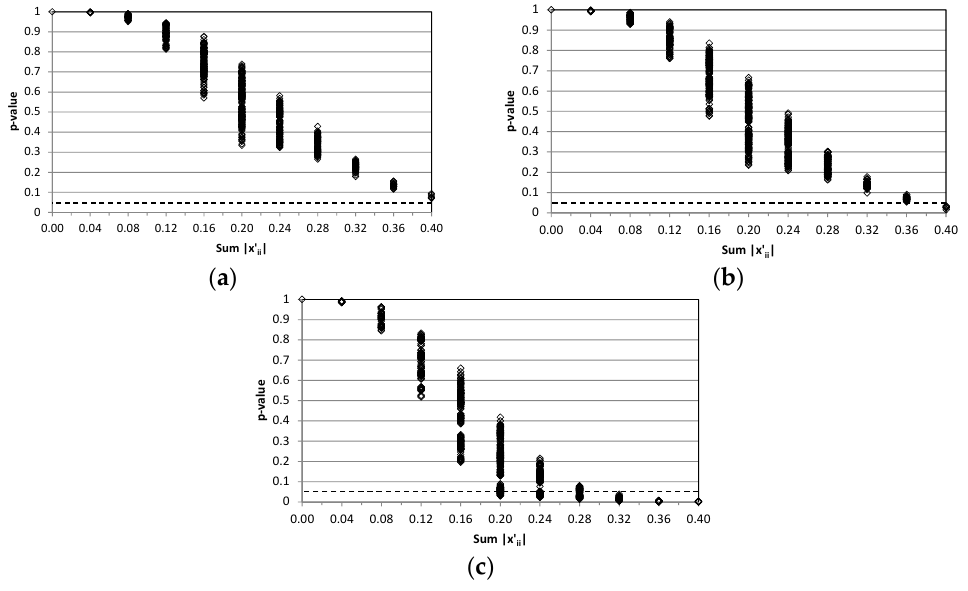
Figure 1. Representation of the p -value for each perturbed matrix. ( a – c ) are the results for CM 95 , CM 80 , and CM 50 , respectively. Cases in which OA remains the same. The x -axis is the sum of the absolute values of the perturbations. The dotted line represents a p -value of 0.05.